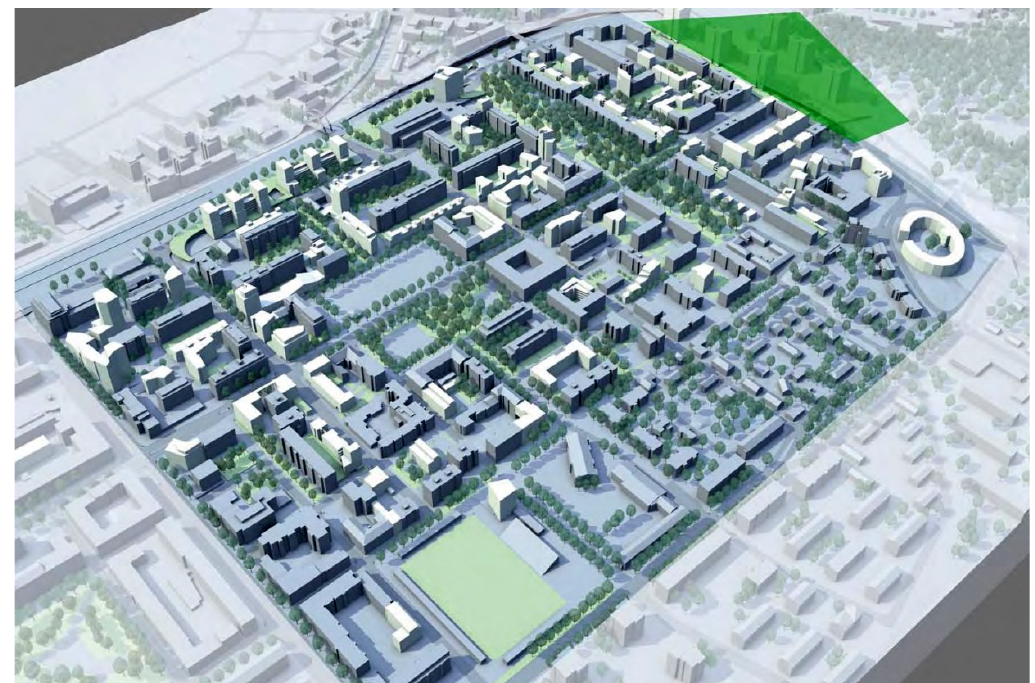
Figure 1. Vision of Tammela’s densification potential (Vision of Tammela, 2012, p. 40). The lighter buildings represent possible new buildings. Later on, planners promoted an even more ambitious densification vision, for example, to build 12-storey apartment buildings around the football stadium